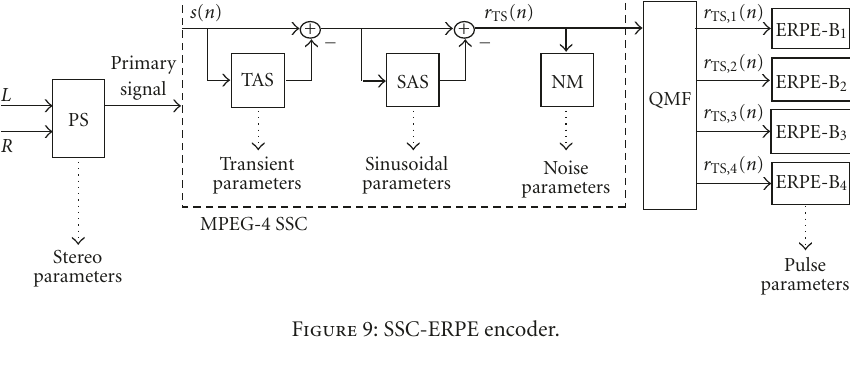
Figure 9: SSC-ERPE encoder.